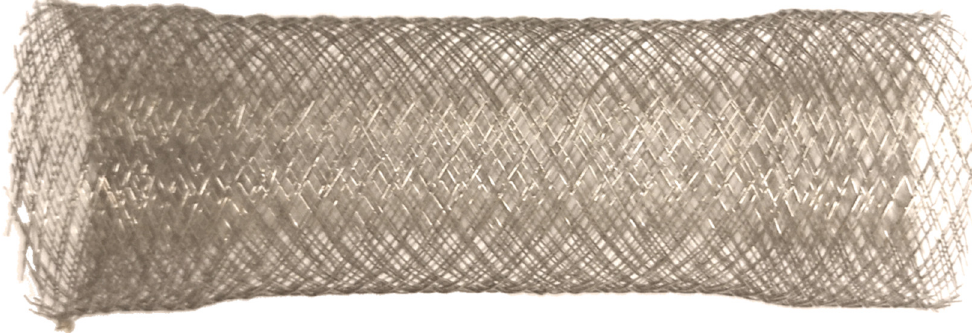
Figure 1. Multilayer Flow Modulator (Cardiatis SA, Isnes, Belgium).